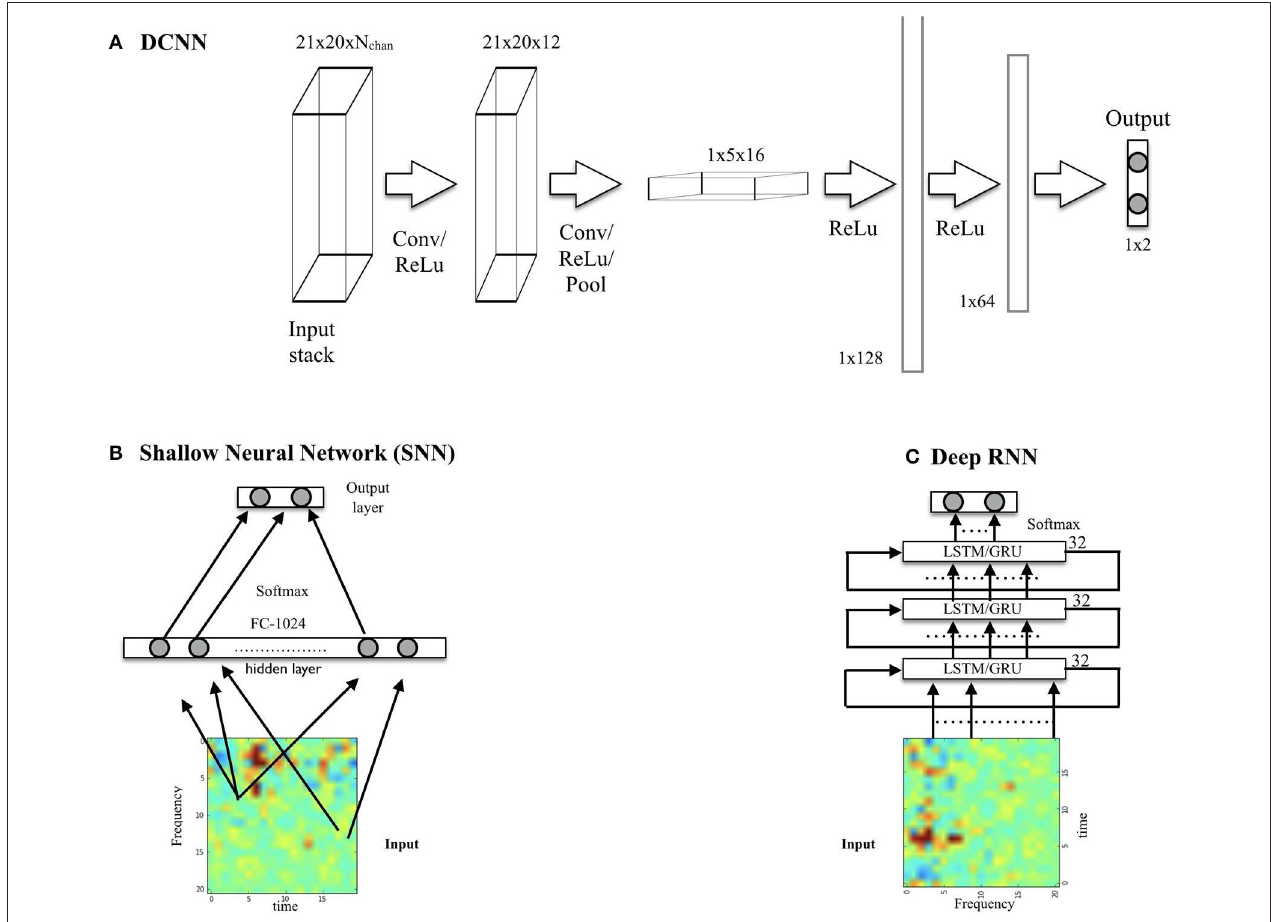
FIGURE 2 | (A) DCNN model displaying input, convolution with pooling layers, and hidden-unit layers. The input consists of a spectrogram stack (with a spectrogram per chosen EEG channel). The output, here for the binary classification problem using one-hot encoding, is a two node layer. (B) Shallow neural network architecture used for comparison. (C) Deep RNN using LSTM or GRU cells.